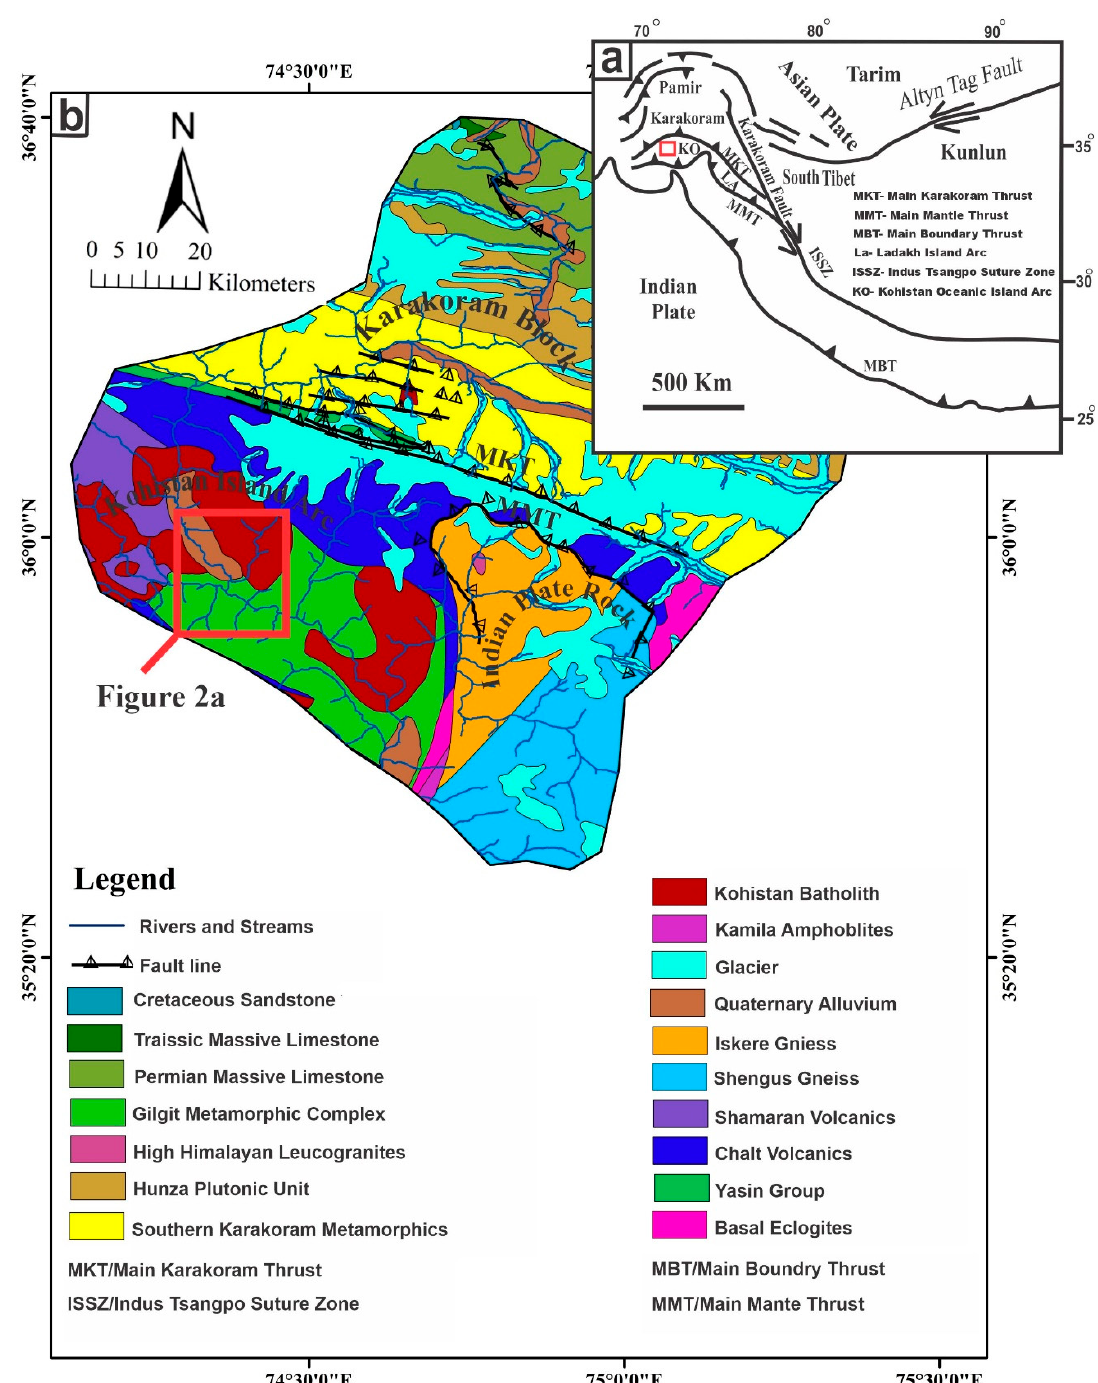
Figure 1. ( a ) Tectonic zones of northern Pakistan modified after [16] and [17]; ( b ) regional geological map showing the main lithological units and tectonic zones of northern Pakistan modified from Searle et al. [9,18] .